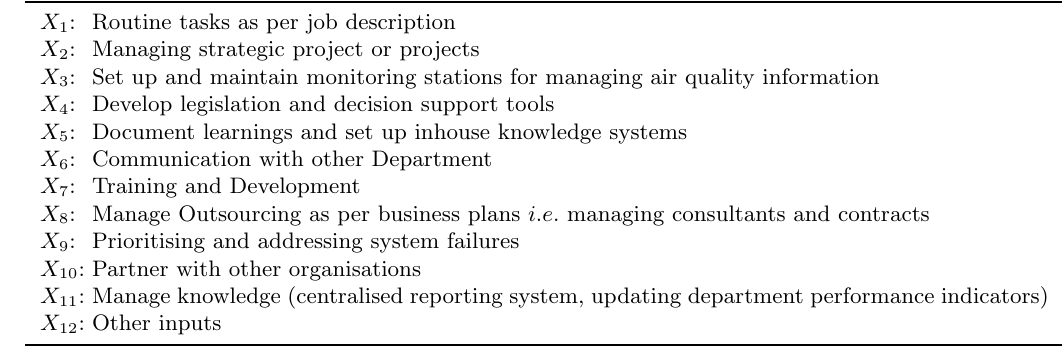
Input variables used in this study. Of these, X 2 , X 6 , X 7 , X 8 , and X 10 are project management input variables, X 3 , X 9 and X 11 are knowledge management input variables, and X 4 and X 5 are change management input